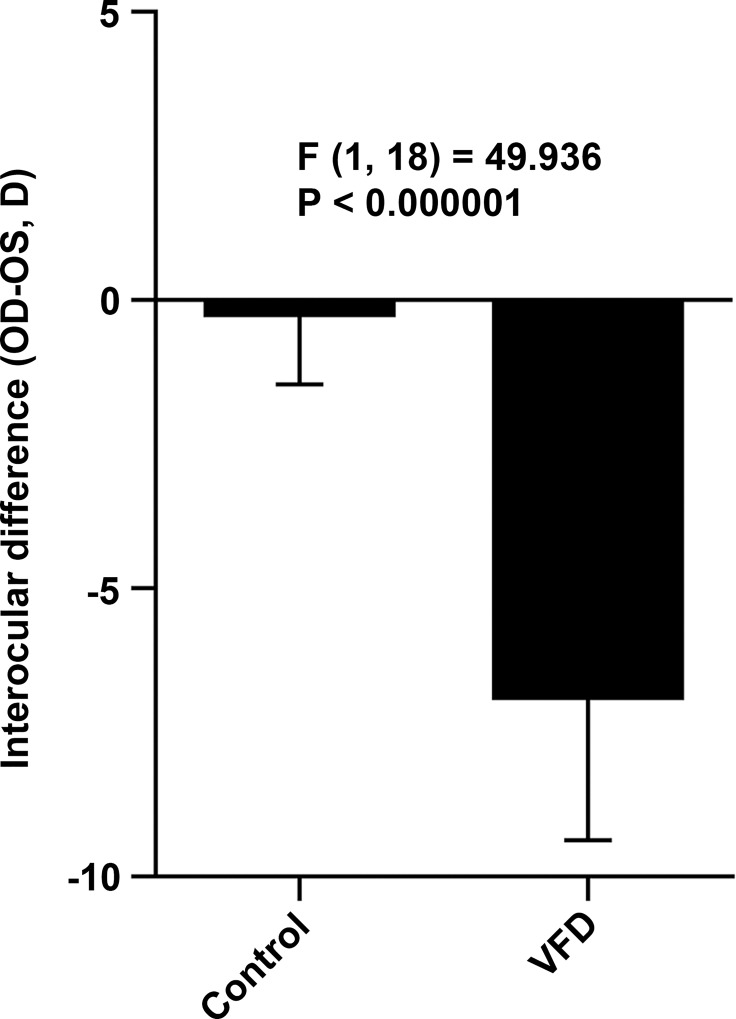
Form-deprivation myopia in C57BL/6J mice.Form-deprivation myopia was induced in C57BL/6J mice by applying a diffuser to the right eye of P24 animals. Ten days of visual form deprivation induced -6.93 ± 2.44 D (p < 0.000001, n = 12) of myopia in the right eyes compared to the contralateral control eyes.